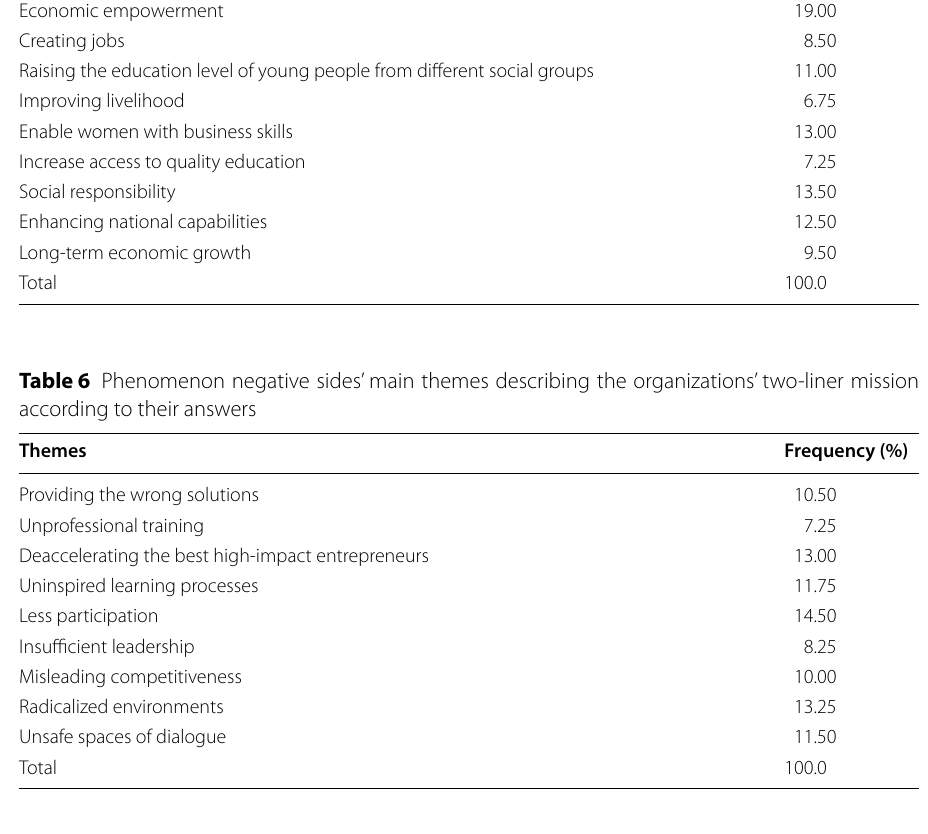
Table 5 Phenomenon positive sides’ main themes describing the organizations’ two-liner mission according to their answers Themes Frequency (%) Economic empowerment 19.00 Creating jobs 8.50